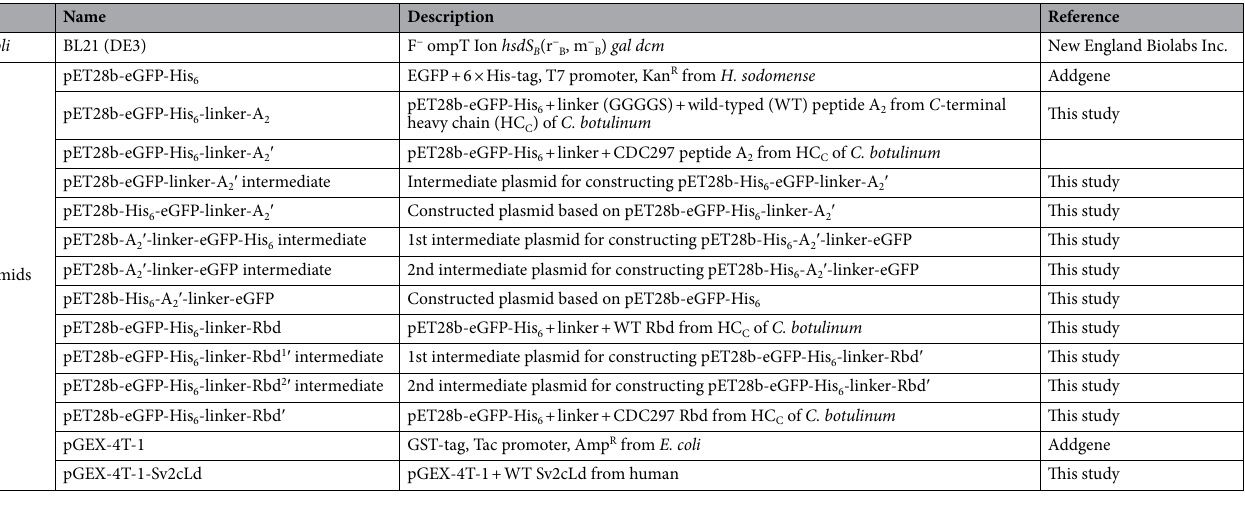
Table 2. E. coli strain and plasmids utilized in this